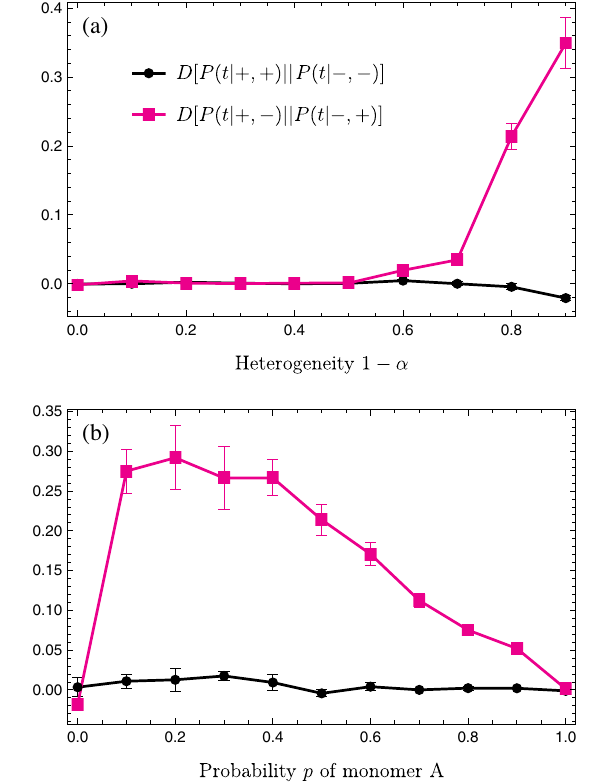
FIG. 15. Kullback-Leibler divergence of the intertransition- time densities for repeated [ D ½ P ð t jþ ; þÞjj P ð t j − ; − Þ(cid:2) , black circles] and alternated [ D ½ P ð t jþ ; − Þjj P ð t j − ; þÞ(cid:2) , magenta squares] transitions obtained from numerical simulations of the model sketched in Fig. 14. We plot the values of these Kullback-Leibler divergences as a function of two parameters of disorder: (a) in terms of heterogeneity 1 − α with fixed monomer probability p ¼ 0 . 5 , and (b) in terms of probability p of monomer A , with fixed α ¼ 0 . 2 . The rates used for Gillespie simulations are W 12 ¼ W 43 ¼ 1 s − 1 , W 21 ¼ W 23 ¼ W 34 ¼ 5 s − 1 , and W 32 ¼ W 14 ¼ W 41 ¼ 4 s − 1 , which leads to a nonequilibrium dynamics, and α is introduced according to Eq. (63). Error bars represent the standard deviation from five trajectories, each of duration 5 × 10 6